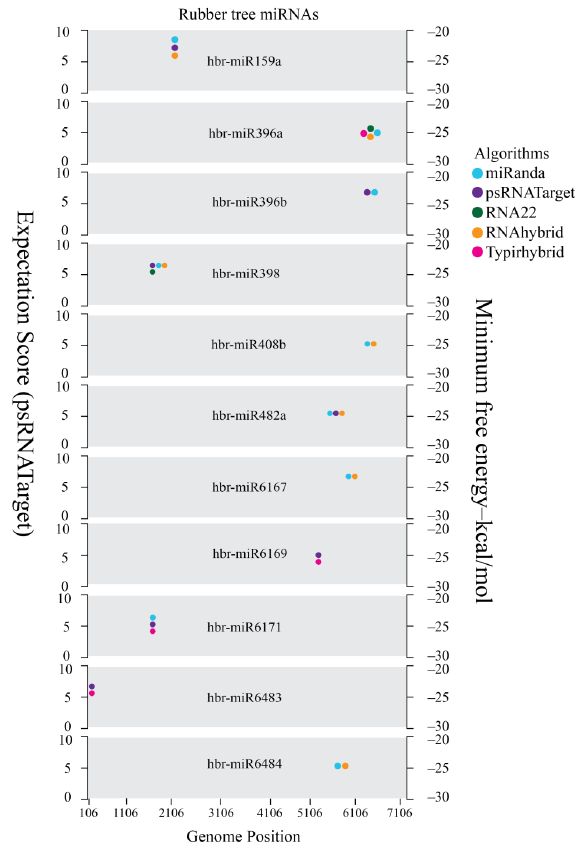
Figure 6. Intersection plot representing consensual rubber tree miRNAs predicted by different algorithms at common locus positions. Minimum free energy (MFE) for potential consensual miRNAs is considered − 20 Kcal/mol by at least two of the algorithms used in this study. MFE (miRanda, RNA22 and RNAhybrid) and expectation cut-off score (psRNATarget) are indicated. Color codes are given within the figure.